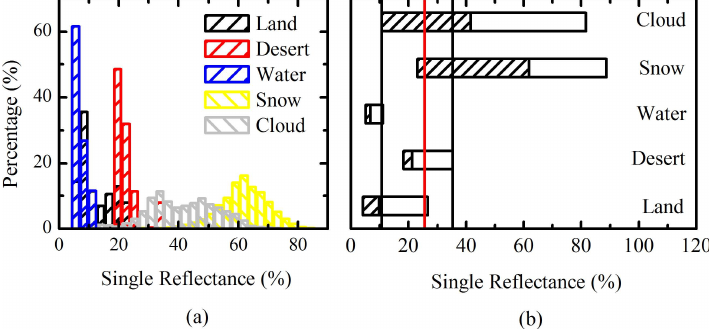
Fig. 2. (a) Histograms and (b) ranges of the reflectance distributions of the different surface types and clouds at channel 1 (0.58–0.68µm) of VIRR during April in 2010; for (b) the locations of the median values shown as slash marks, the low limit and high limit for clear skies vs. clouds and snow shown as black lines, T shown as red line.